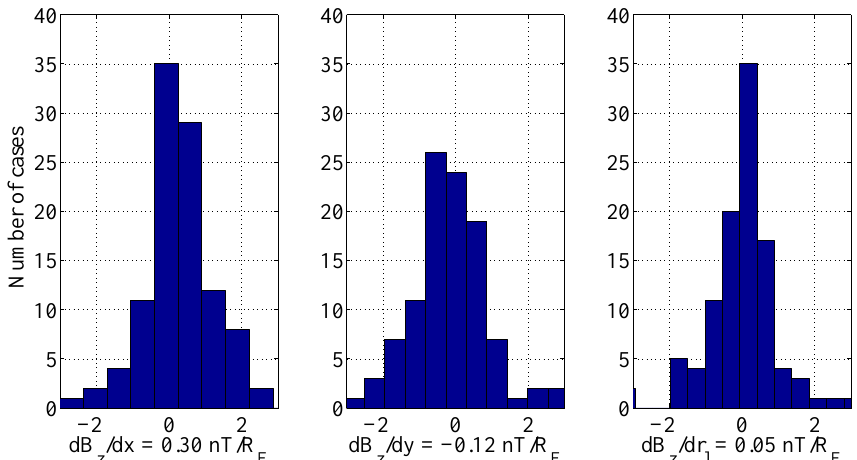
Figure 4. The gradients ∂B z /∂x , ∂B z /∂y and ∂B z /∂r l of magnetic field B z in the CS centre for each CS crossing.